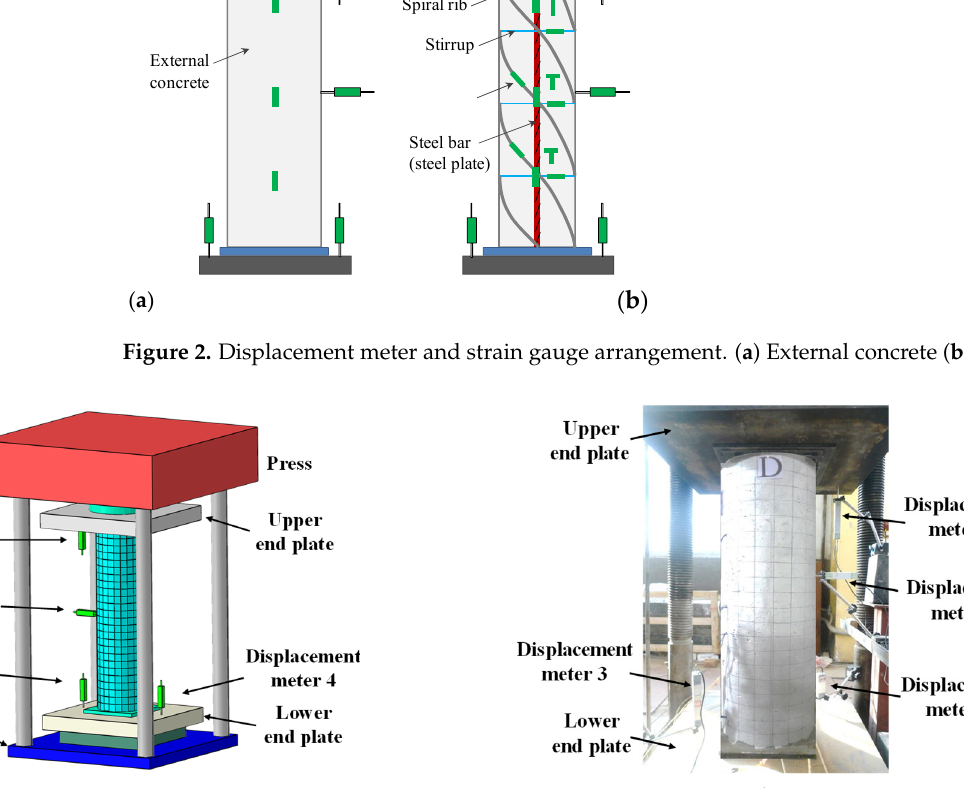
Table 3. Steel material properties .